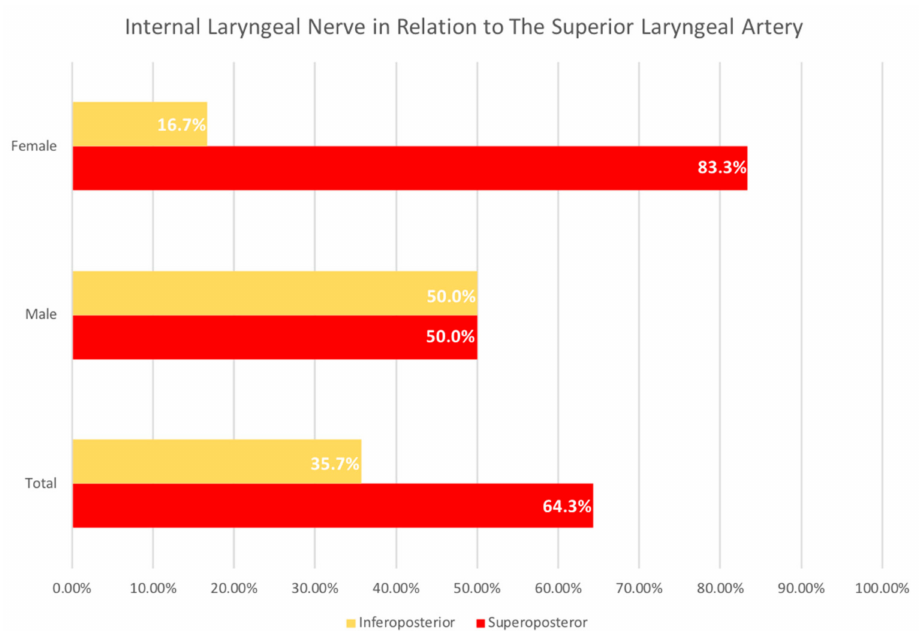
Figure 2. The Relationship of the Internal Laryngeal Nerve to the Superior Laryngeal Artery. Analysis of the frequency based on the relationship of the internal laryngeal nerve (ibSLN) to the superior laryngeal artery (SLA) showed, out of 14 samples, 64.3% of the ibSLN are related superoposterior to the SLA, while 35.7% are related inferoposterior to it. When stratified by sex, the ibSLN is more commonly related superoposterior to the SLA in female cadavers (83.3%) compared to inferoposterior relationship, which is more common in male cadavers